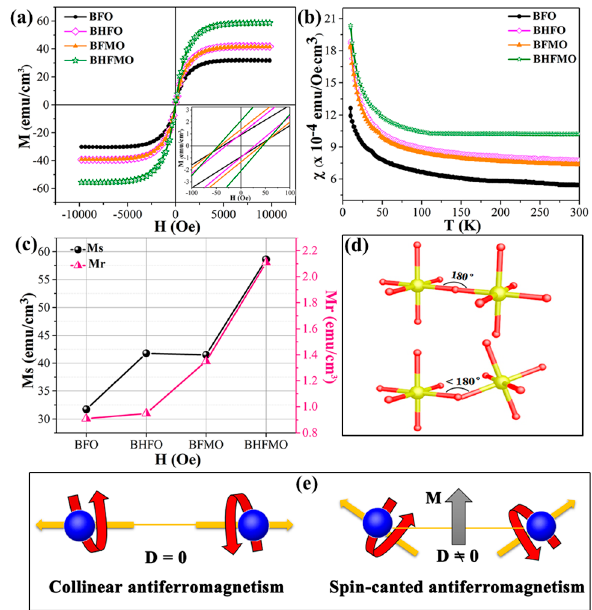
Figure 7. ( a ) Magnetic hysteresis loops measured at room temperature with the field applied in the plane for BFO, BHFO, BFMO and BHFMO thin films; The inset in ( a ) shows the enlarged M-H loop of all thin films; ( b ) Temperature dependence of magnetic susceptibility of BFO, BHFO, BFMO, BHFMO thin films as measured in an external magnetic field of 1000 Oe. For these measurements field-cooled (FC) conditions have been chosen; ( c ) The tendency of Mr and Ms for these samples; ( d ) Fe-O-Fe super-exchange interaction in the BFO and doped BFO thin films; ( e ) Canted antiferromagnetism spin configuration causes net magnetization in doped BFO thin film by the Dzyaloshinskii-Moriya interaction.